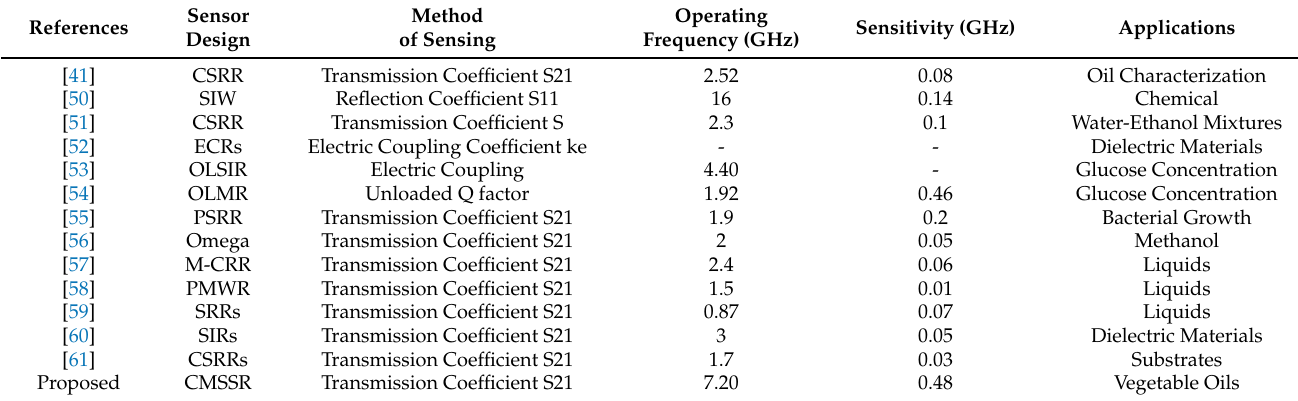
Table 6. Comparison of the proposed complementary metaresonator sensor with various state of art